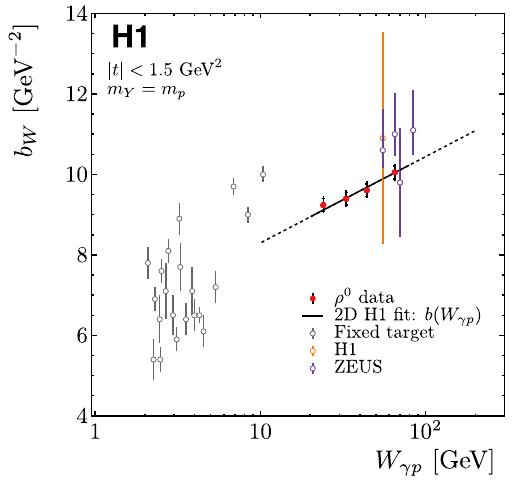
Fig. 18 Fit parameters b W as a function of W γ p for the elas- tic ( m Y = m p ) differential ρ 0 meson photoproduction cross section d σ(γ p → ρ 0 Y )/ d t ( t ; W γ p ) . The parameters are obtained from fits of modified exponential functions to the t distributions in all W γ p bins, as describedinthetext.CorrespondingmeasurementsbyHERA[9,15,17] and fixed-target [20–25] experiments are also shown. The plotted curve depicts the dependence b ( W γ p ) expected from the leading Regge tra- jectory parameters that are extracted from the present data as described in the